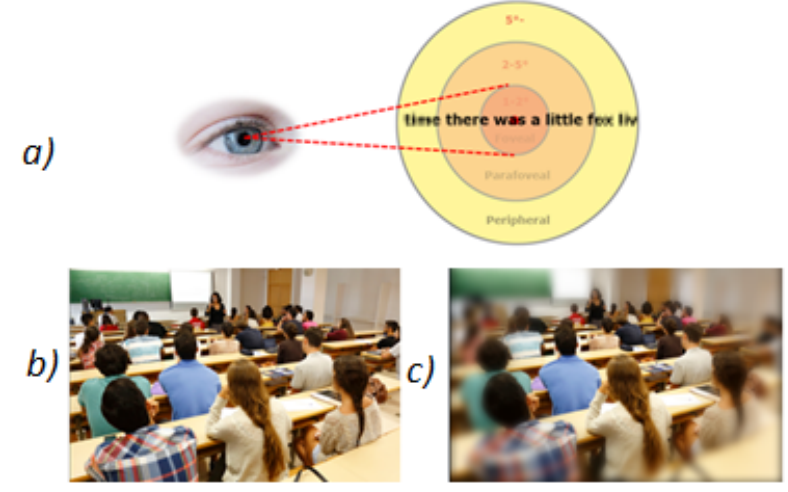
Figure 2. Comparison between an image obtained by computer vision vs. human vision.